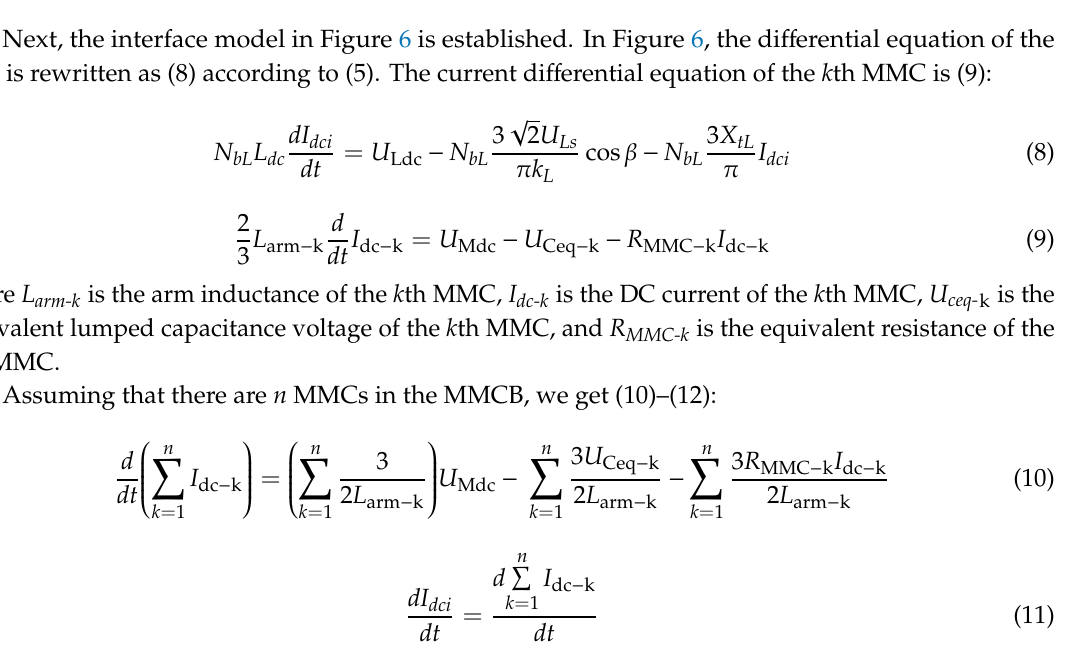
Figure 6. The DC side equivalent circuit diagrams of the decentralized inverter